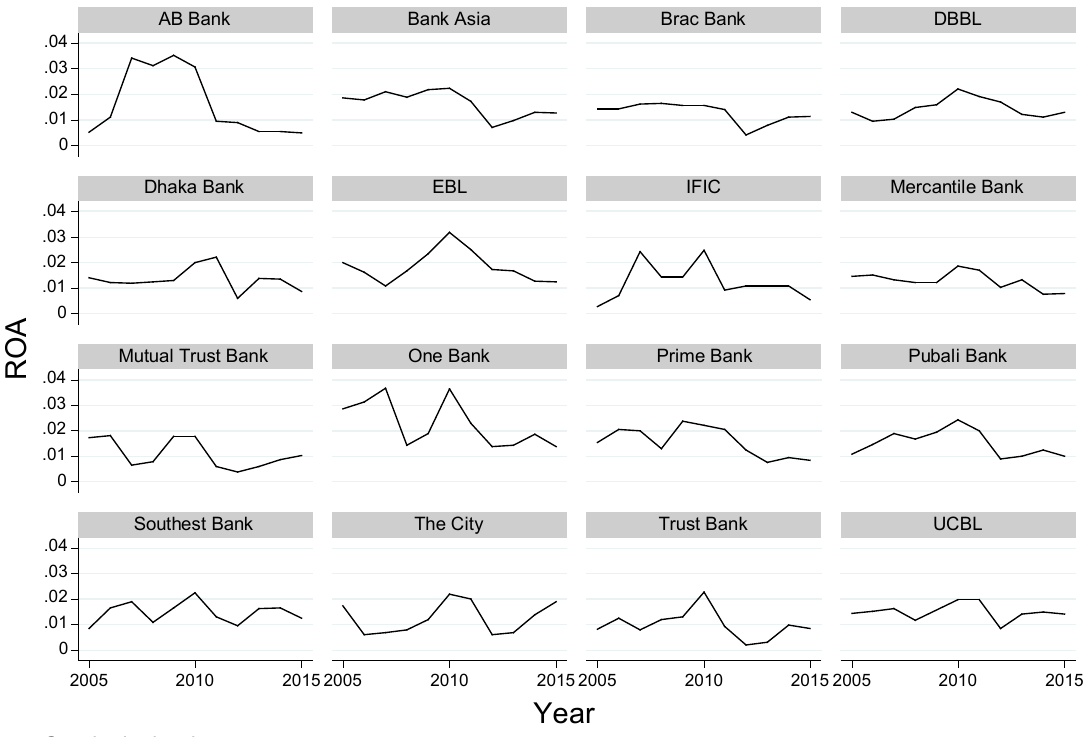
Figure 11. Comparison of the return on asset from the period 2005 to